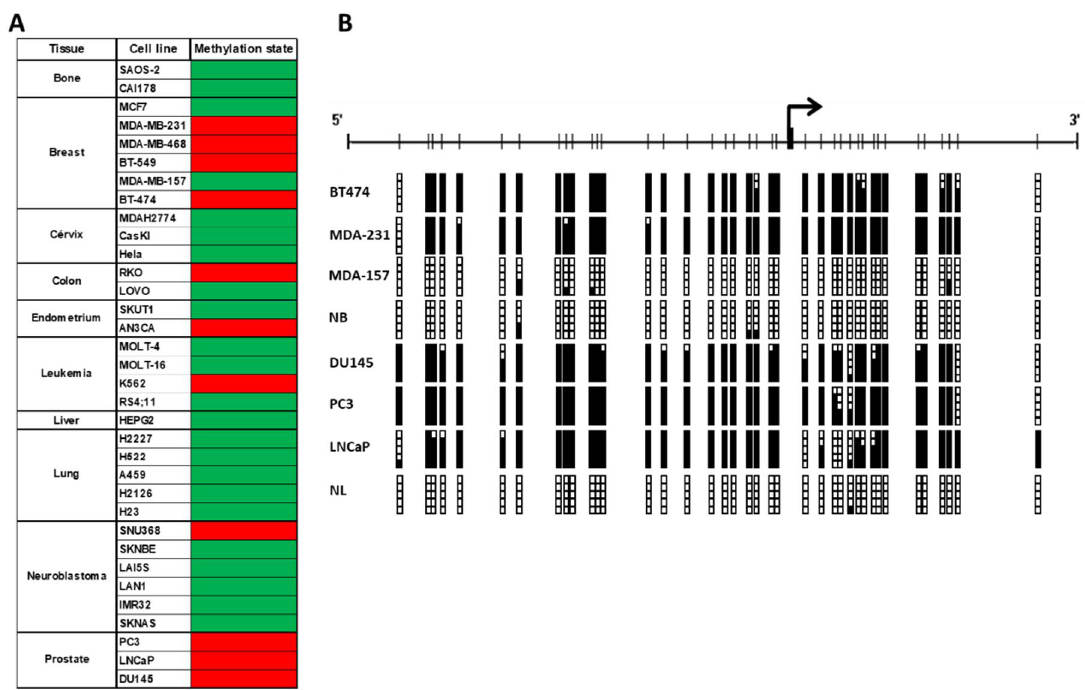
Figure 1. ( A ) Analysis of Gfi1 methylation status in human cancer cell lines. Methylated or unmethylated cell lines are showed by red or green squares respectively. ( B ) Schematic depiction of the Gfi1 promoter region around the corresponding transcription start site (thick black arrows). CpG dinucleotides are represented as short vertical lines. Results of bisulfite genomic sequencing of 5 individual clones are shown. Presence of a methylated or unmethylated cytosine is indicated by a black or white square, respectively.